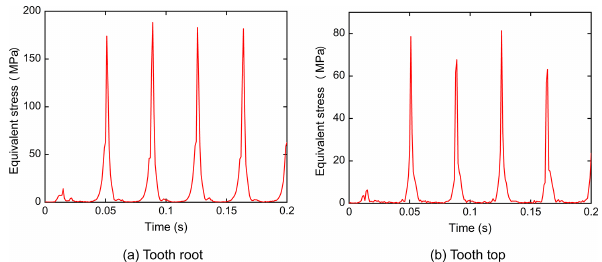
Figure 9. Equivalent stress of dynamic meshing on the nutation external bevel gear.